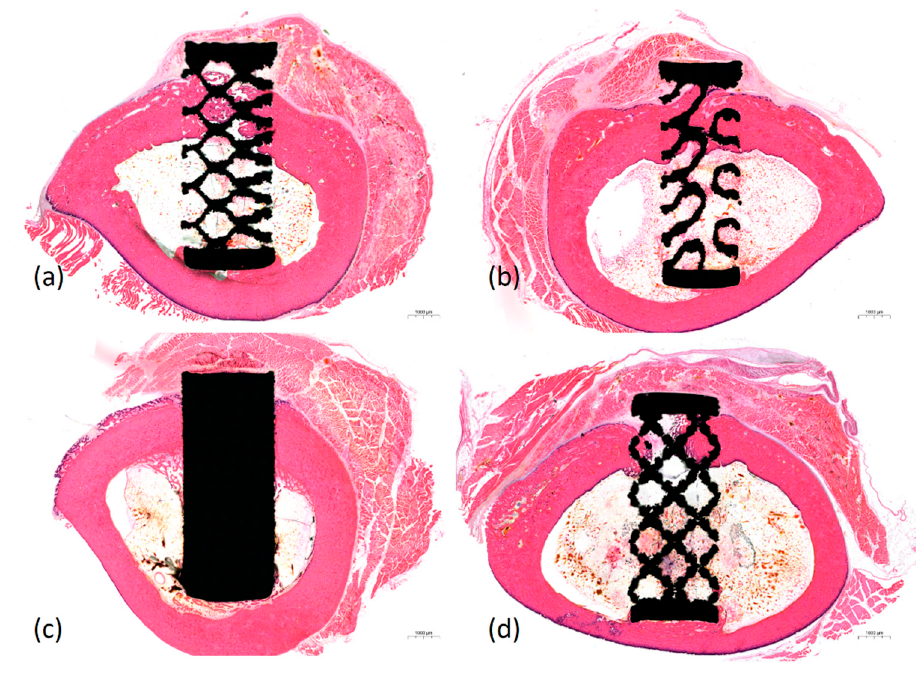
Figure 5. Histological images of the titanium specimens with four different pore designs. ( a ) Octadens pore design. ( b ) Gyroid pore design. ( c ) Solid. ( d ) Dode pore design (H&E staining, X1.0).